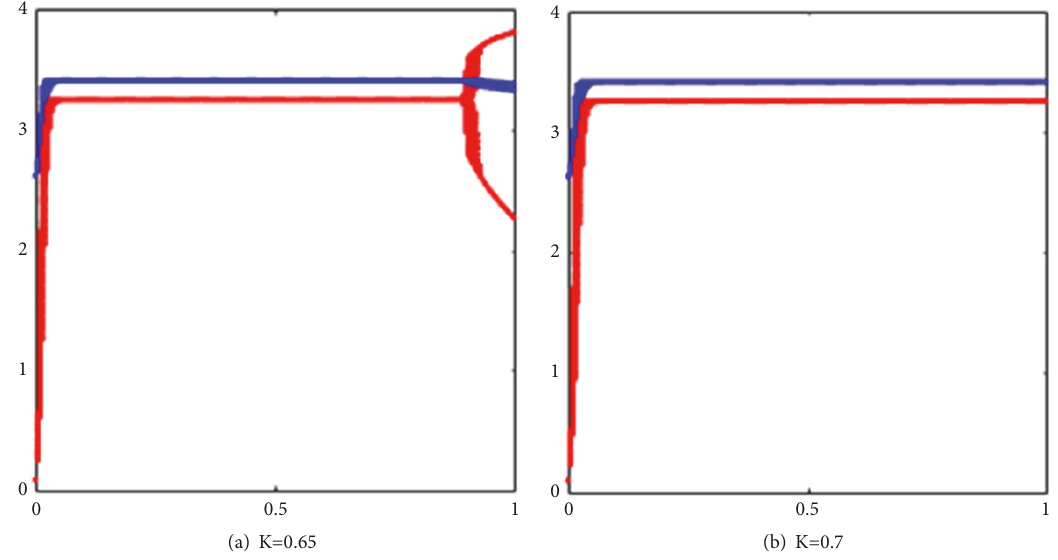
Figure 14: Bifurcation diagram with respect to diffident K: (a) K=0.65; (b) K=0.7.